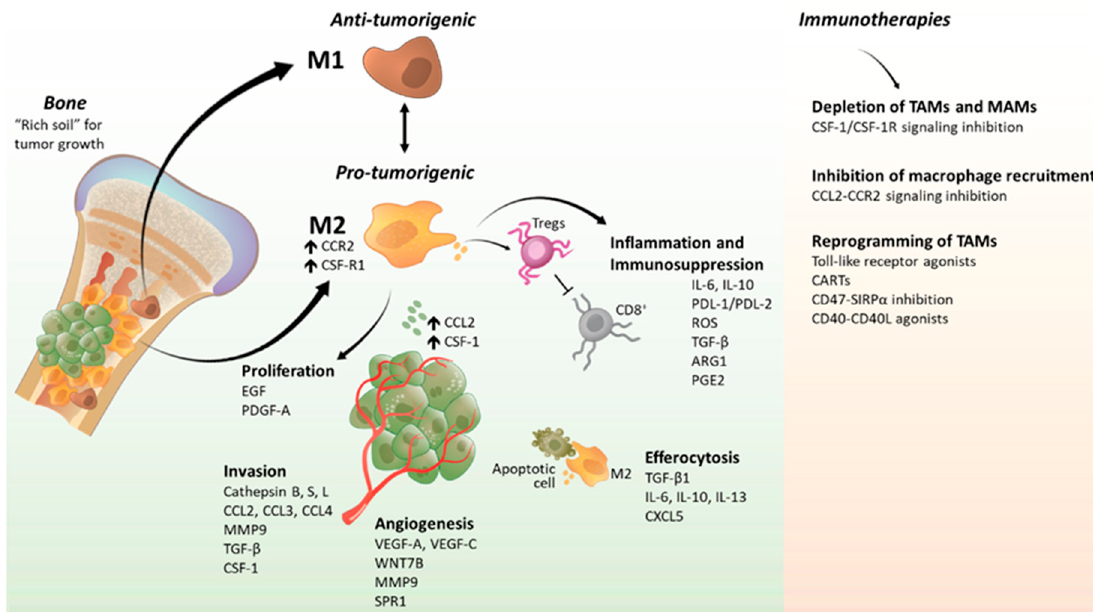
Figure 2. The role of macrophages in tumor development and bone metastases. The bone microenvironment is a “rich soil” for tumor growth. Tumor associated macrophage polarization towards the M2 phenotype promotes the development of the metastatic cascade that contributes to the development of skeletal metastases once the bone is colonized by metastatic cancer cells. Various immunotherapeutic strategies are currently under clinical trials in order to find effective treatments.